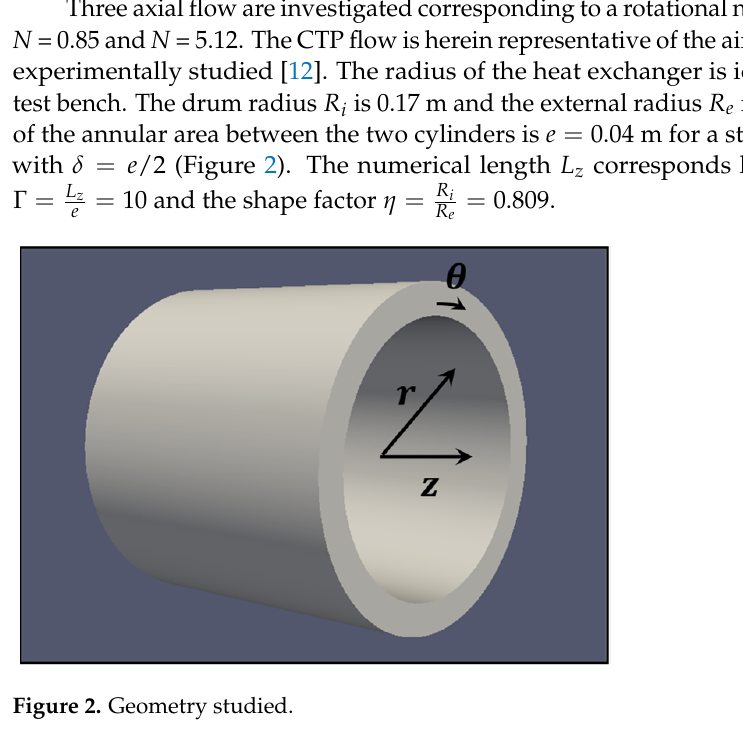
(Figure 2). The numerical length (cid:1838)